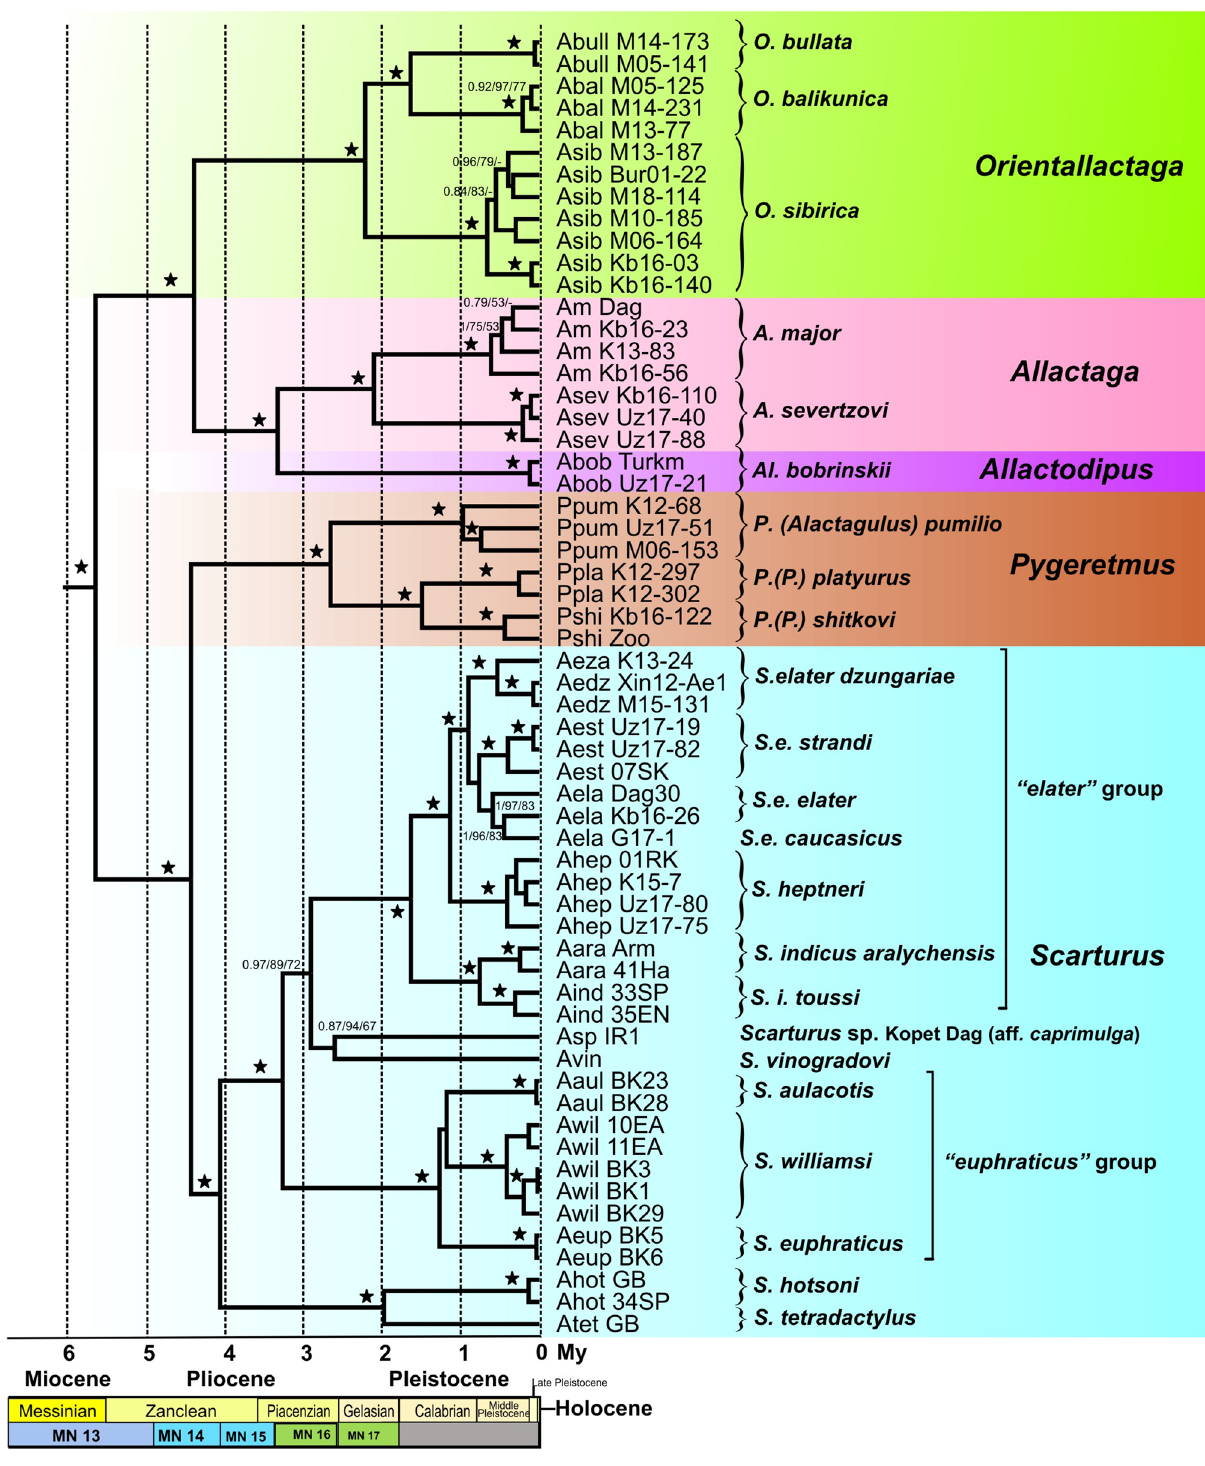
Figure 2. Chronogram of the divergence events in the Allactaginae produced by the BEAST algorithm based on the analysis of nuclear genes. Values above the branches correspond to posterior probabilities in Bayesian analysis (≥ 0.75) and bootstrap support (1000 pseudoreplicates, ≥ 50%) in the ML and MP analyses, respectively (BPP/ML/MP). Asterisks mark the nodes with absolute support in all analyses. Relationships among outgroup lineages are shown in Fig.